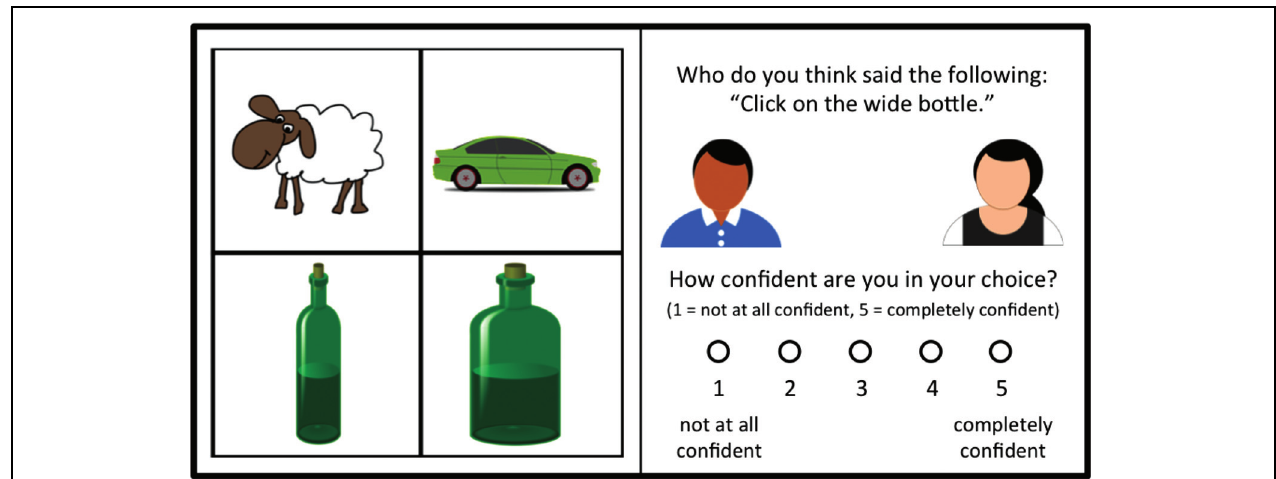
FIGURE 2 | In the Generalization Phase participants saw 2x2 image grids (left) above the transcribed instructions, avatars that represented the two speakers, and a confidence rating scale (right).